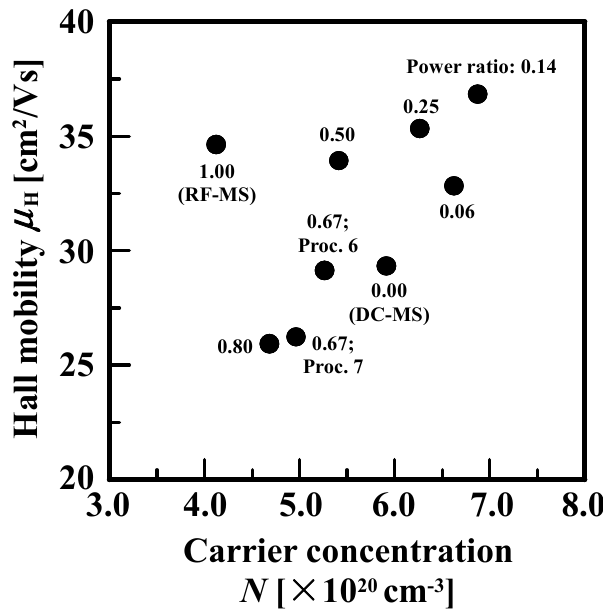
Figure 1. Hall mobility ( μ H ) vs. carrier concentration ( N ) of 500-nm-thick AZO films deposited by DC magnetron sputtering (DC–MS), RF/DC magnetron sputtering at various power ratios, and by RF magnetron sputtering (RF–MS).